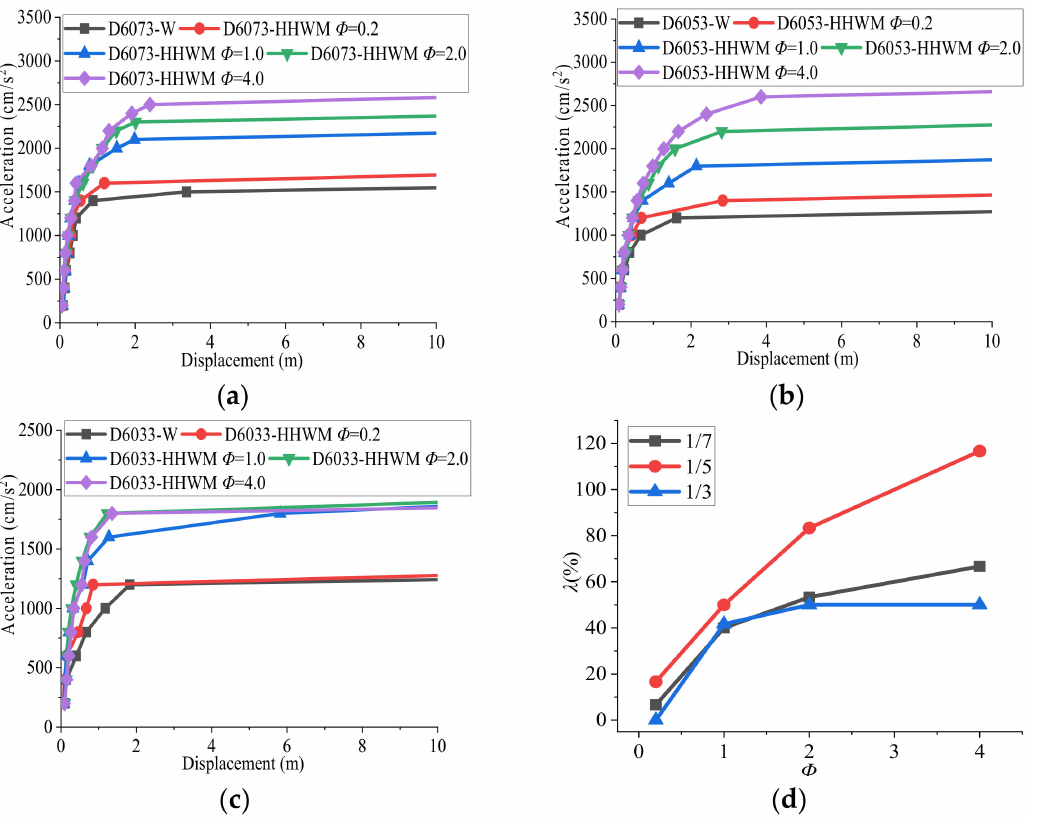
Figure 15. Seismic response curves of the shells with different purlin joint coefficients and the Φ - λ relationship: ( a ) D6073; ( b ) D6053; ( c ) D6033; ( d ) Φ - λ